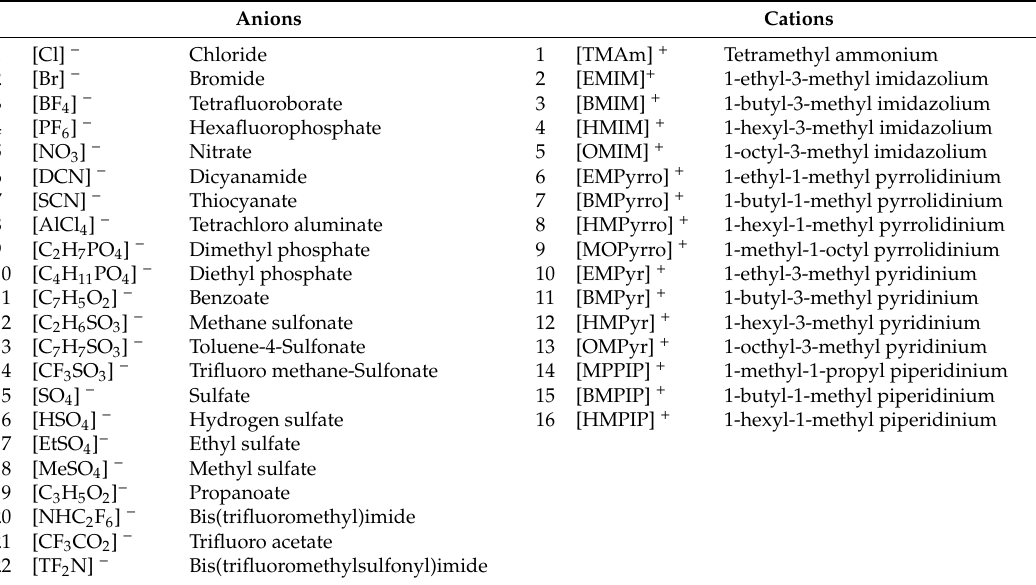
Table 2. Classification of anion- and cation-based ILs utilized in this study.